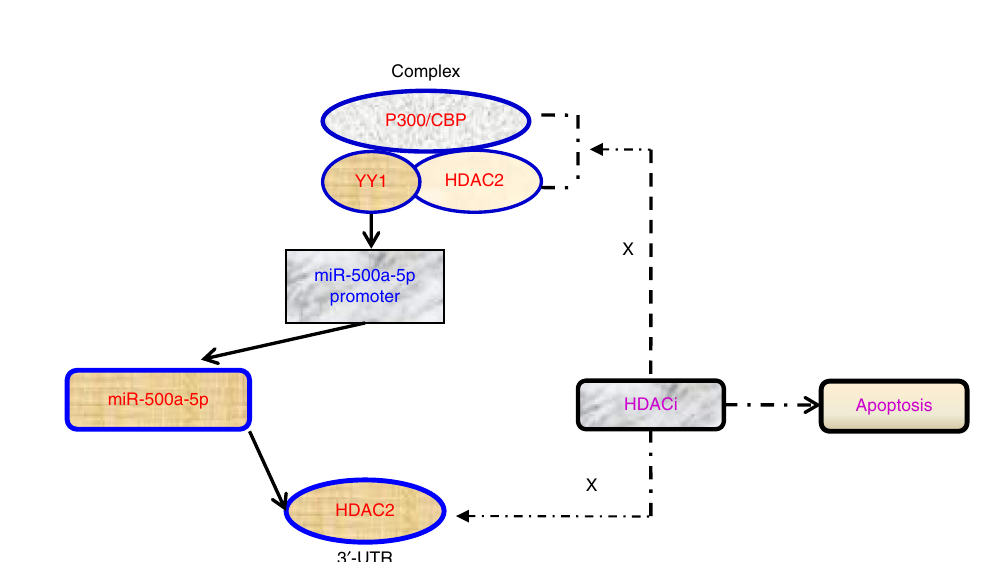
Fig. 8 Illustration of the hypothesised signal mechanism of miR-500a-5p. Dashed line: HDAC2 was blocked by the HDACi (HDAC